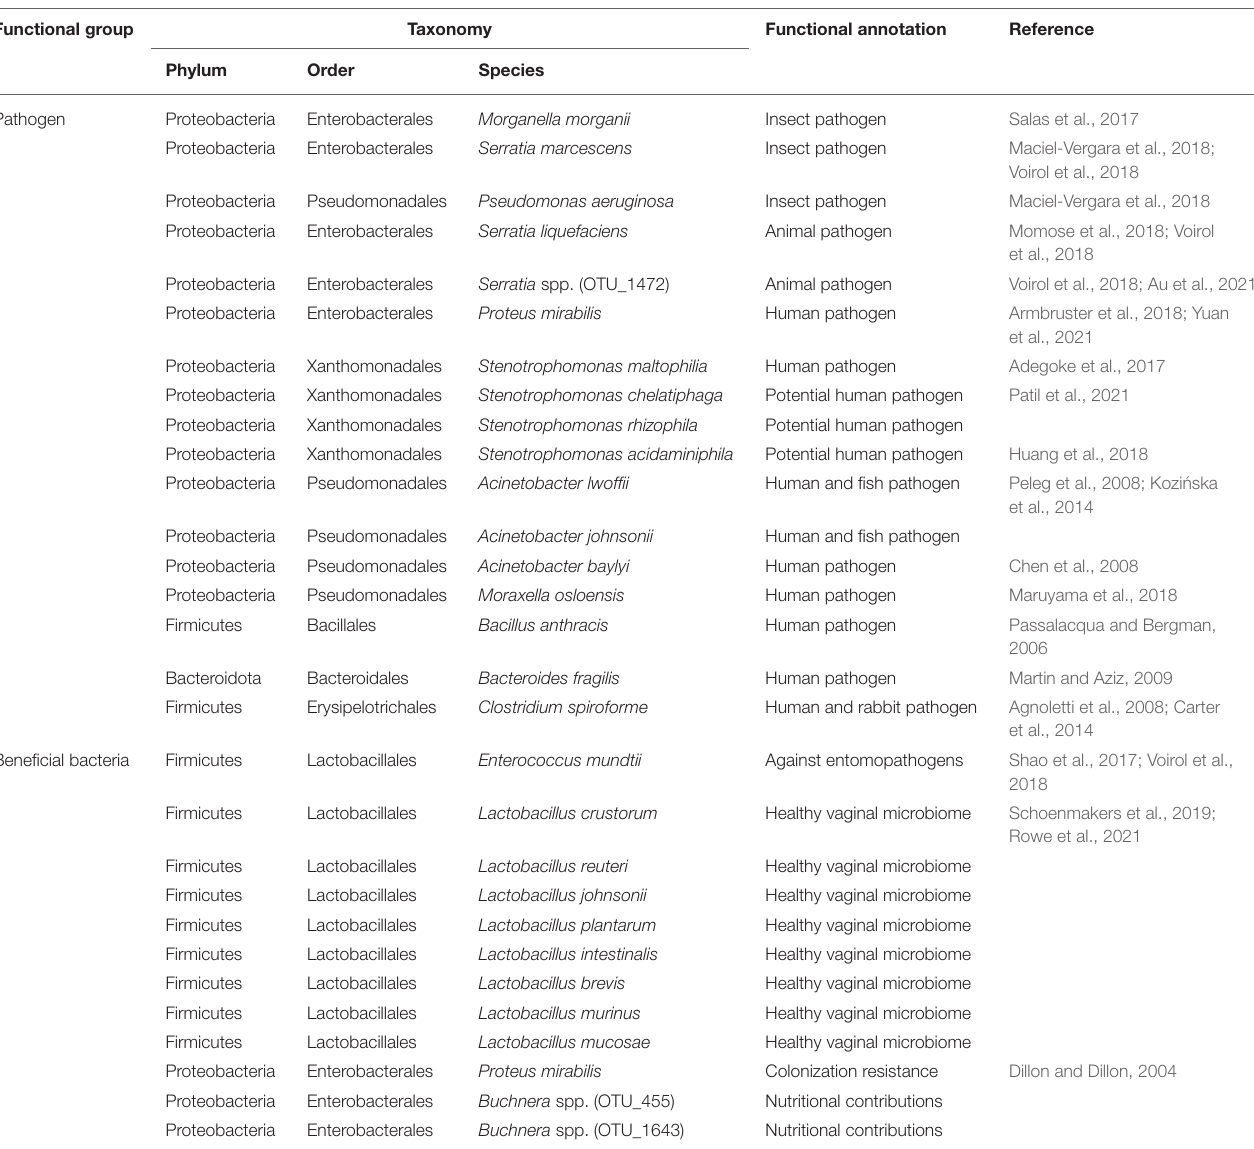
TABLE 1 | Possible pathogens and beneficial bacteria * profiles in S. frugiperda